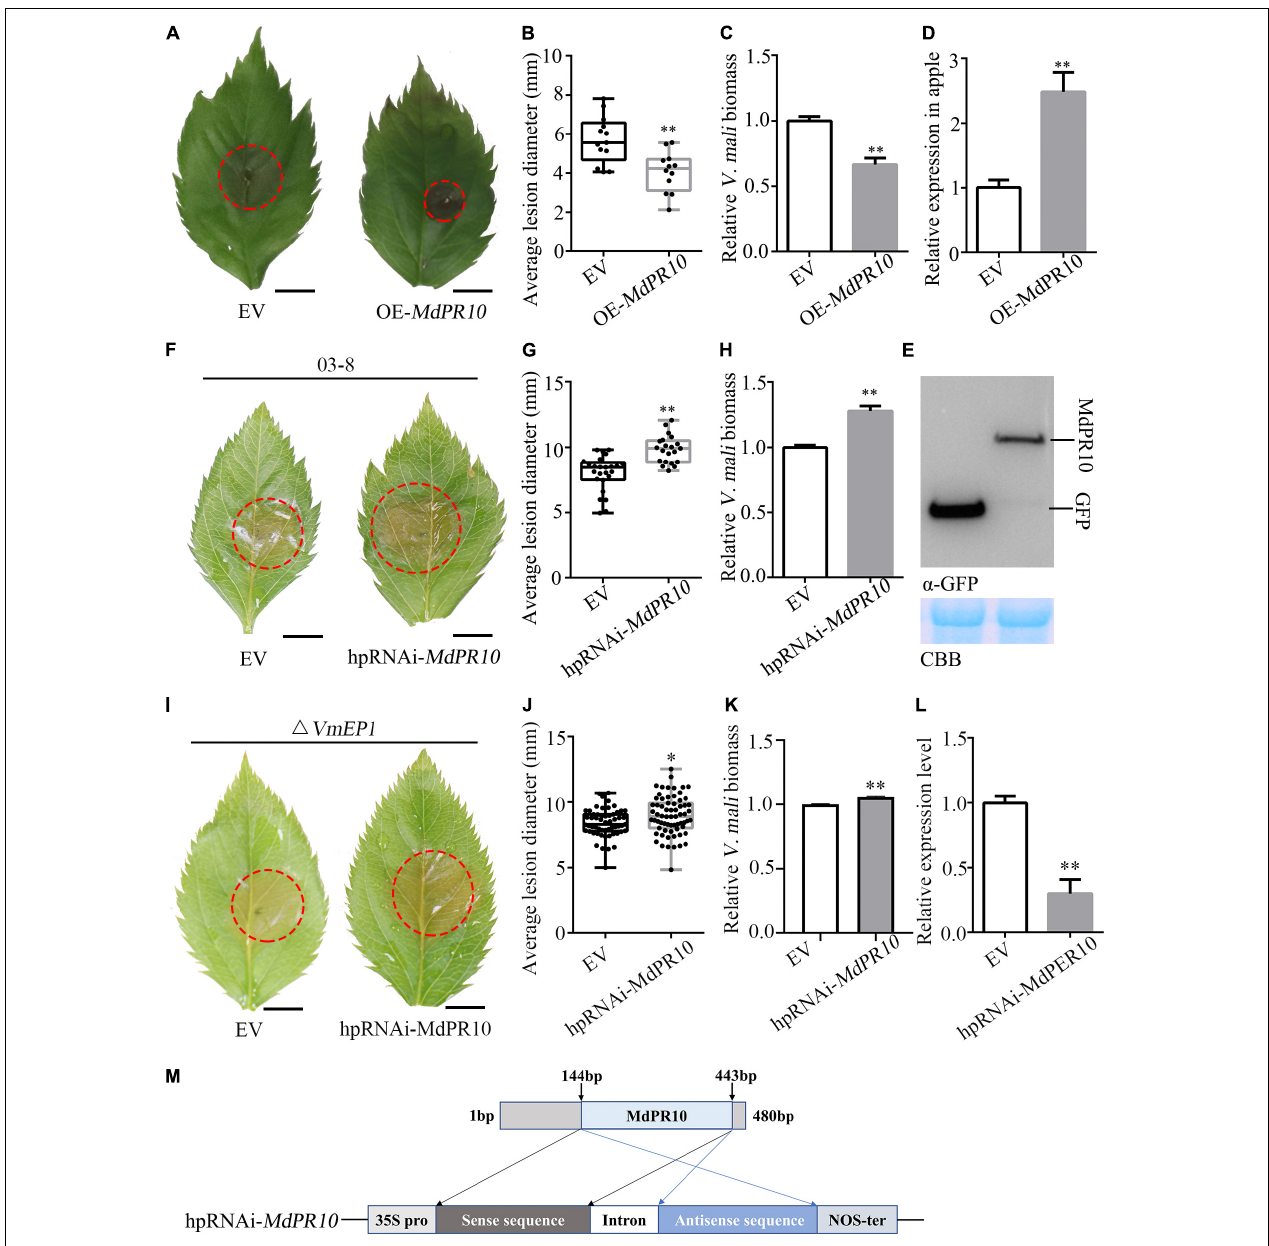
FIGURE 3 | Apple ( Malus domestica ) pathogenesis-related protein 10 positively contributes apple resistance to V . mali . (A) Representative disease symptoms of the apple leaves transiently expressing MdPR10 at 36 h after inoculation of V . mali . Bars = 5 mm. (B) The average lesion diameter in the apple leaves in which MdPR10 is transiently expressed was evaluated at 36 hpi of V . mali . (C) The mRNA level of MdPR10 in the apple leaves, as revealed by reverse transcription-quantitative polymerase chain reaction (RT-qPCR) 2 days after infiltration of OE- MdPR10 . (D) V . mali biomass was measured with qPCR at 36 hpi. (A–D) EV, pCAMBIA1302 empty vector; OE- MdPR10 , the apple leaves overexpressing MdPR10 . (E) Immunoblot analysis of proteins in apple transiently expressing GFP control and MdPR10 fused with GFP tag. (F) Representative disease symptoms of the apple leaves in which MdPR10 is silenced at 36 hpi of V . mali . Bars = 5 mm. (G) The average lesion diameter in the apple leaves in which MdPR10 is silenced was evaluated at 36 hpi of V . mali . (H) V . mali biomass was measured with qPCR at 36 hpi of V . mali . Relative V . mali biomasses were normalized to the mean of the wild-type. (I) Representative disease symptoms of the apple leaves silencing MdPR10 after inoculation of VmEP1 deletion mutants of V . mali . Bars = 5 mm. (J) The average lesion diameter in the apple leaves in which MdPR10 is silenced was evaluated at 36 h after the inoculation of VmEP1 deletion mutants of V . mali . (K) The V . mali biomass was measured with qPCR at 36 hpi of the VmEP1 deletion mutants of V . mali . The relative V . mali biomasses were normalized to the mean of the wild-type. (L) Silence efficiency detection of MdPR10 in apple leaves by RT-qPCR 5 days after the infiltration of hpRNAi- MdPR10 . (M) Schematic of the constructs used to silence MdPR10. hpRNAi- MdPR10 were cloned into the pFGC5941 binary vector. In panels (E–L) EV, pFGC5941 empty vector; hpRNAi- MdPR10 , apple leaves in which MdPR10 is silenced. In panels (B,F,J) mean ± SD; n > 10; ∗ P < 0.05, ∗∗ P < 0.01; Student’s t -test. In panels (C,D,G,H) mean ± SD; n = 3; ∗∗ P < 0.01; Student’s t -test. The genome DNA of the apple leaves was extracted and the relative V . mali biomass was estimated by DNA-based quantitative PCR (qPCR). These experiments were repeated three times with similar results.